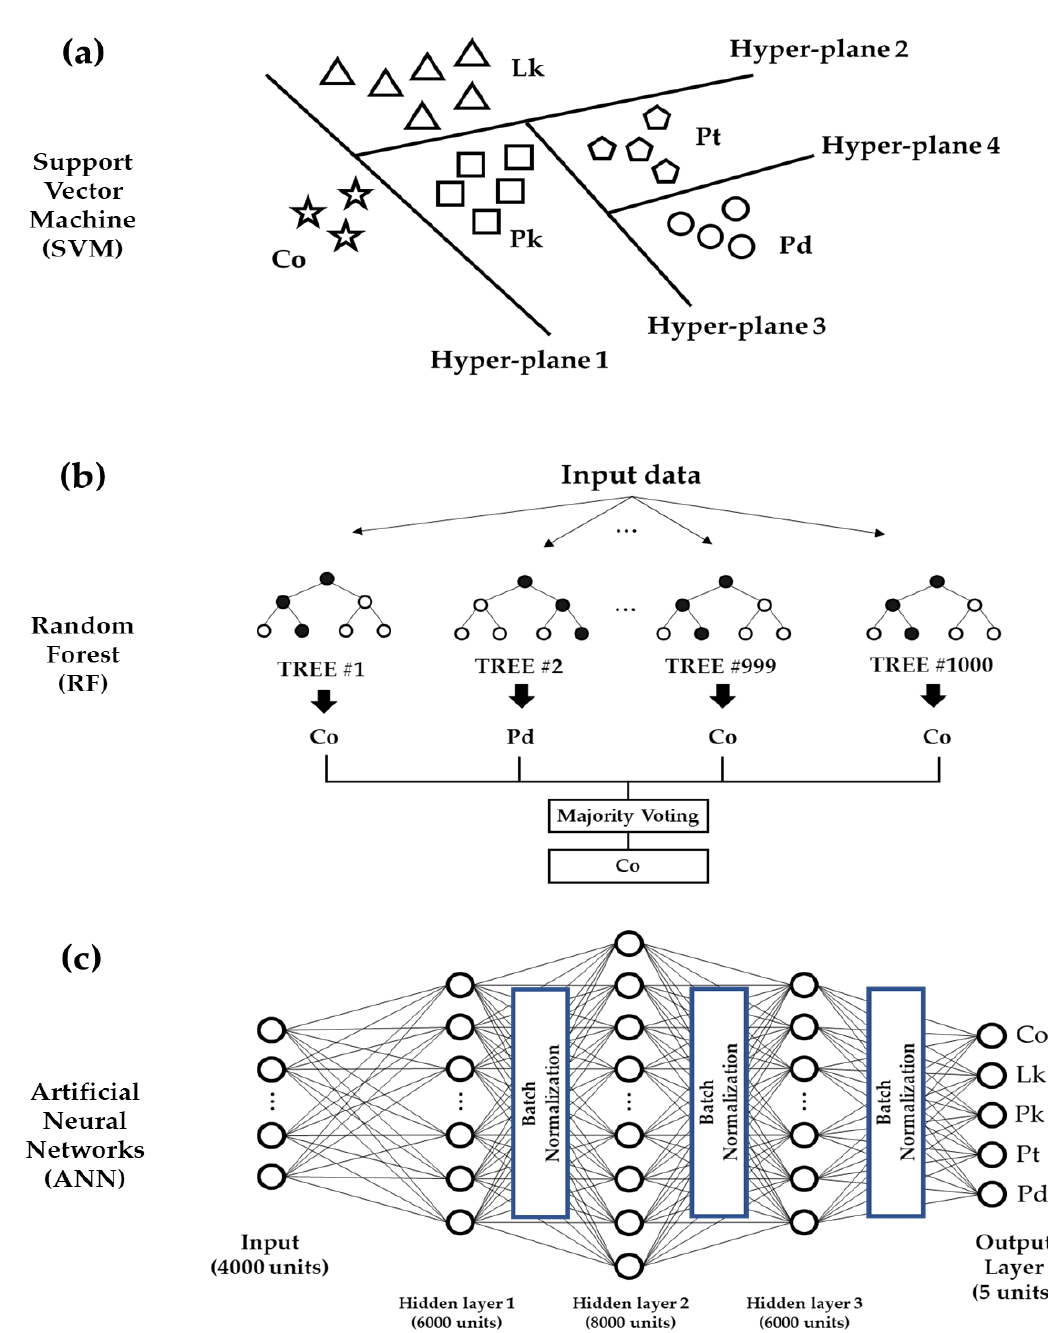
Figure 2. Illustrations of the machine learning models: ( a ) support vector machine; ( b ) random forest; ( c ) artificial neural networks.